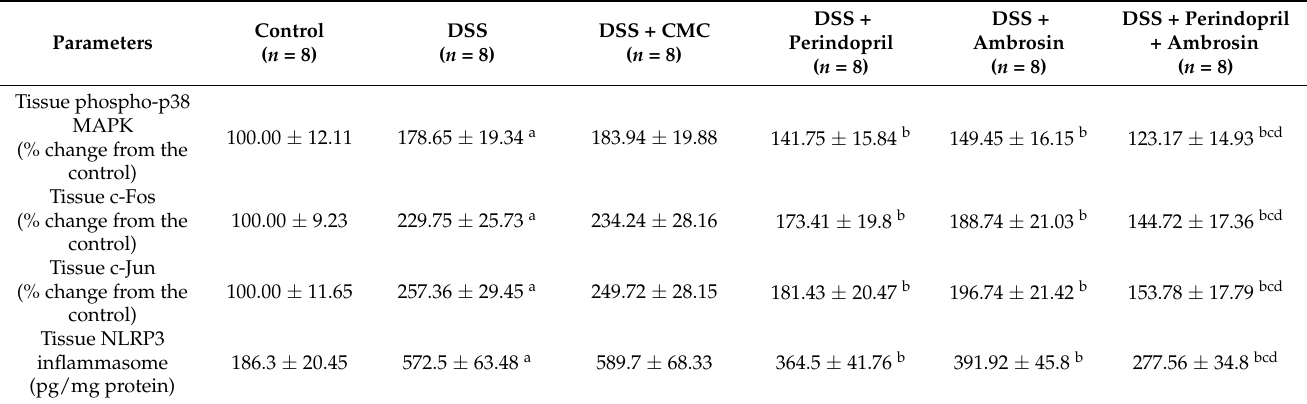
Table 4. Effect of perindopril with or without ambrosin on phospho-p38 MAPK, c-Fos, c-Jun, and NLRP3 inflammasome in the colonic tissues of dextran sulphate sodium (DSS)-treated mice (Mean ± SD).